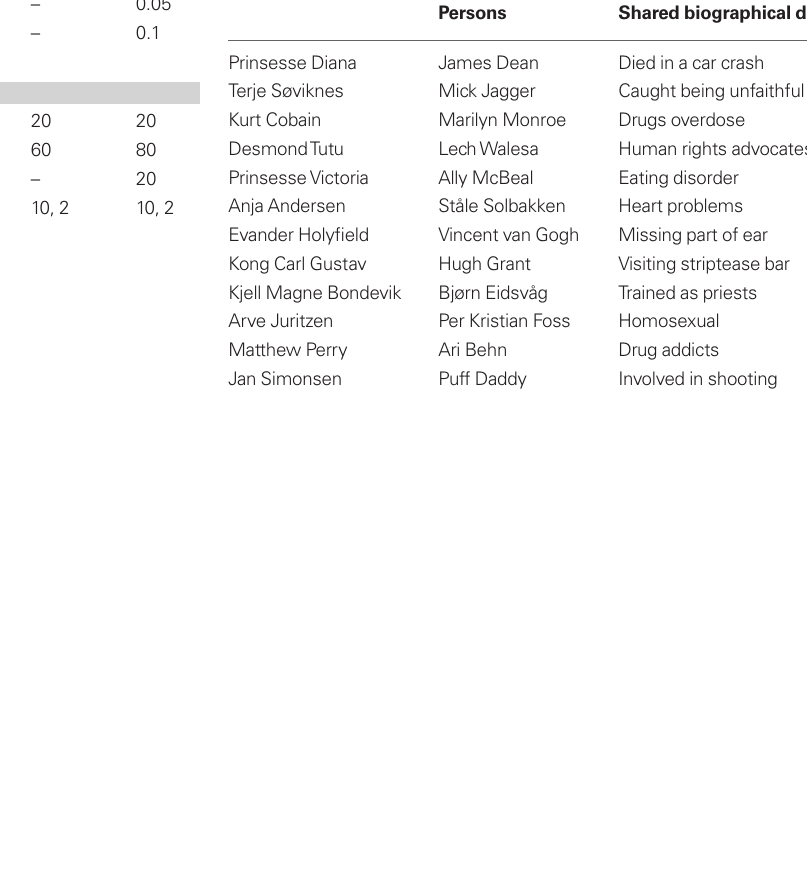
Table A4 | The related pairs of stimuli used in experiment 2, with their single related